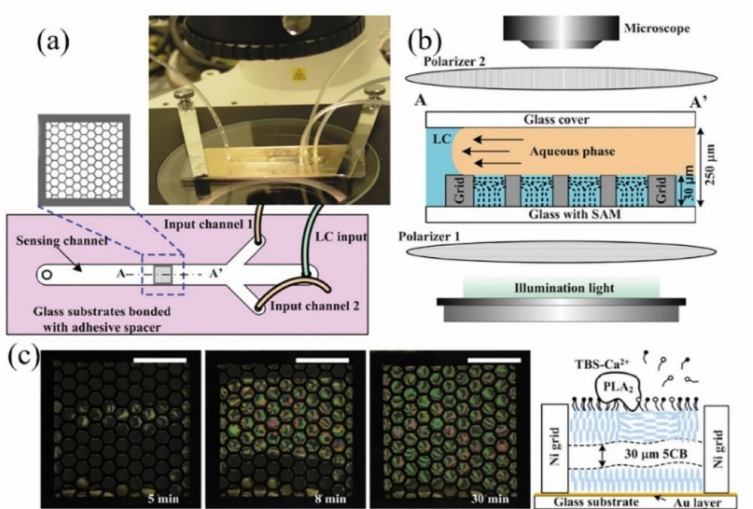
Figure 3. ( a ) Schematic illustration and photograph of microfluidic device for the fabrication of LC-aqueous interface. ( b ) Schematic illustration of the formation of LC-aqueous interface within the microchannel. ( c ) The gradual optical appearance transitions of L-DLPC-decorated LC-aqueous interface within the microchannel after the addition of phospholipase A 2 in the presence of Ca 2+ and the related LC ordering transition mechanism. Reprinted with permission from ref. [51]. Copyright 2012 Royal Society of